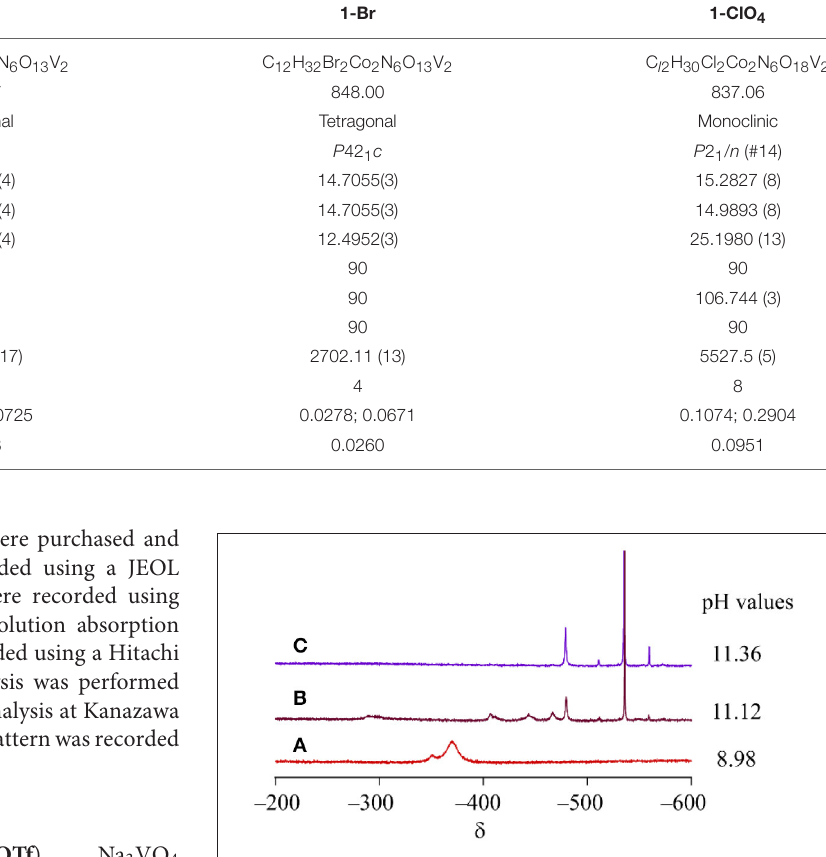
correction were performed on APEX3 program (Bruker,